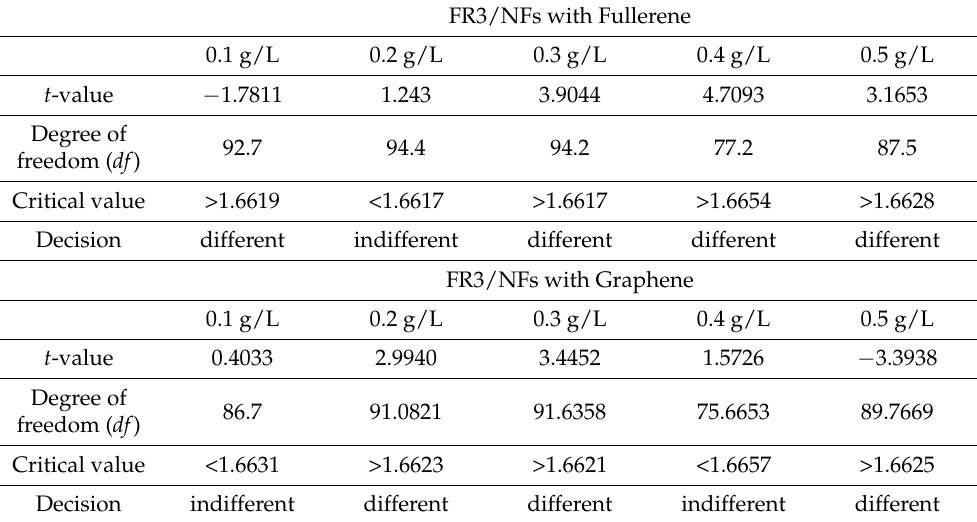
Table 3. t -test results summary.